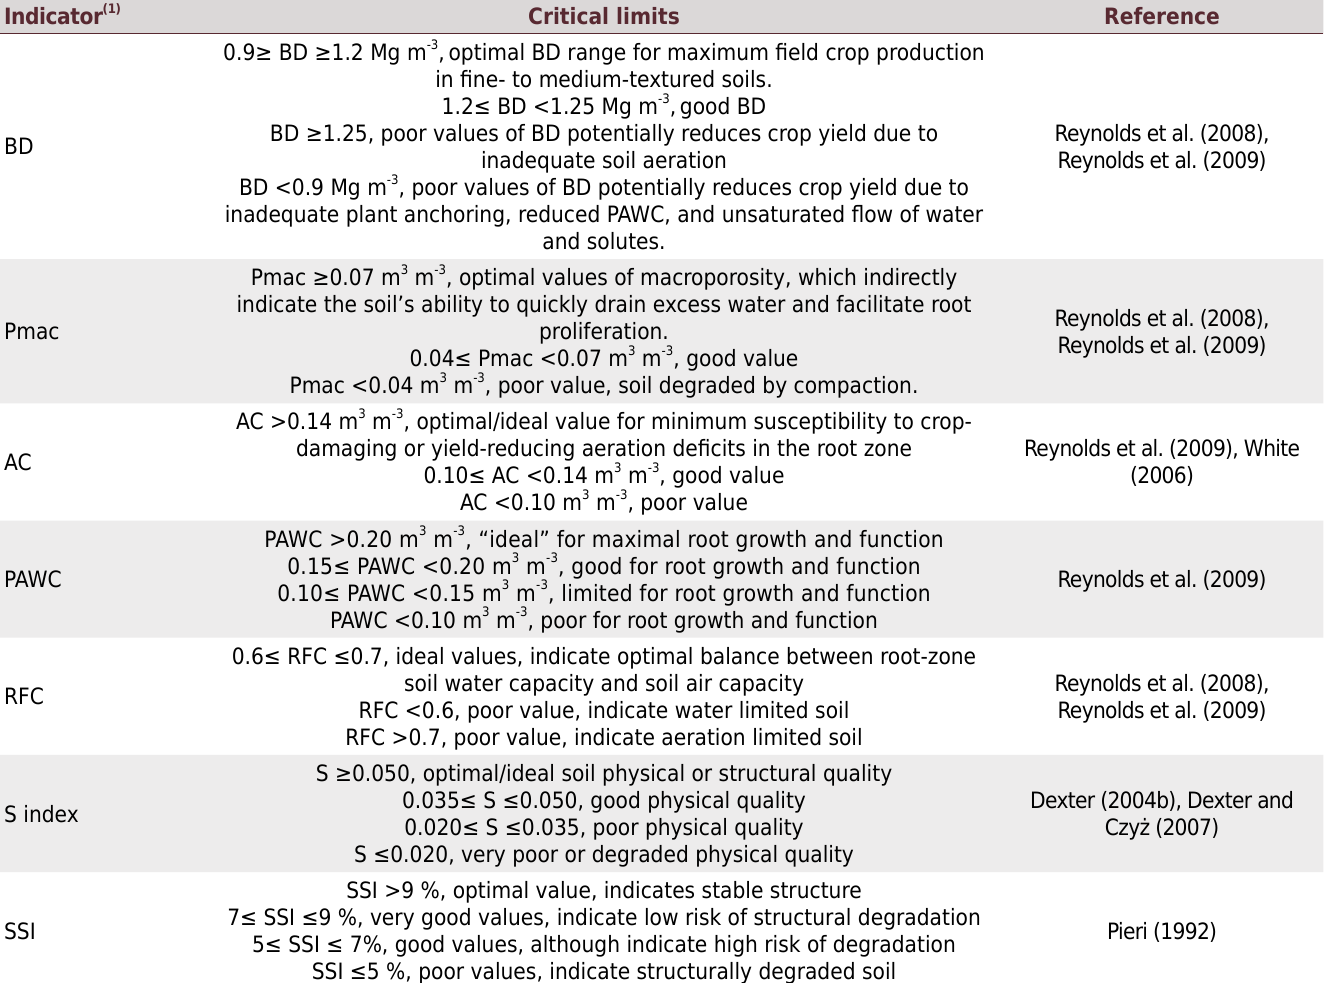
Table 1. Reference ranges and critical limits of capacity soil physical quality indicators Indicator